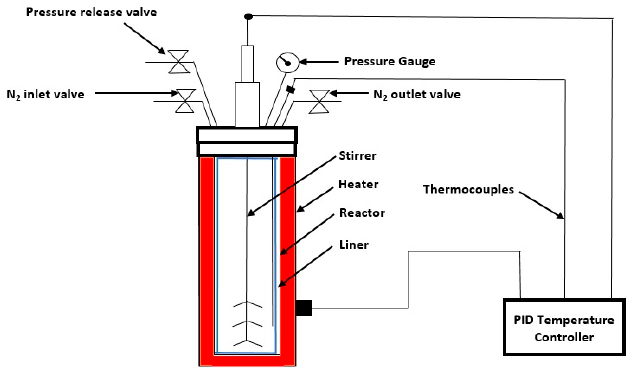
Figure 1. Schematics of the lab-scale experimental set up of the HTC process. The pressure during the experiment was monitored with a pressure gauge fitted at the top of the reactor. For controlling the temperature of the process, a PID temperature controller was used. To evaluate the impact of different operating conditions during the hydrothermal carbonization process, the experiments were performed at various operat- ing temperatures and residence times (15, 30 and 45 min) suggested by the Design Expert 11 software. Firstly, around 10 g of as-received biomass samples were placed in the glass liner and mixed with deionized water at approximately a 1:12 biomass water ratio. The liner was inserted, and the HTC reactor was closed with the reactor head by the bolts. To create an air-free environment inside the reactor, it was purged 5–6 times by the nitrogen gas prior to the reaction. The reactor was then pressurized to 1.5–2.0 MPa (absolute) to ensure the pressure in the reactor was maintained higher than the water saturation pres- sure. The heater was then used to heat the reactor. A thermocouple was placed inside the reactor, which was coupled with the data-logger to record the temperature of the biomass- water mixture. When the internal temperature reached the desired HTC temperature, the stopwatch was started, and the reactor temperature was maintained within ±5 °C for the duration of the experiment.